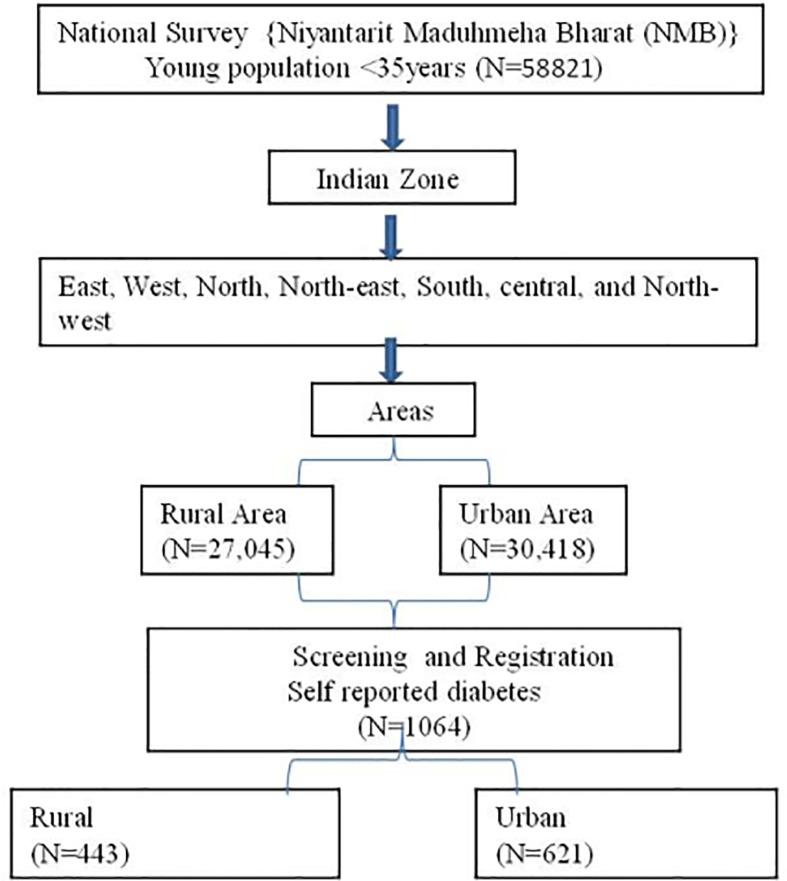
Population sampling strategy of nationwide NMB study.